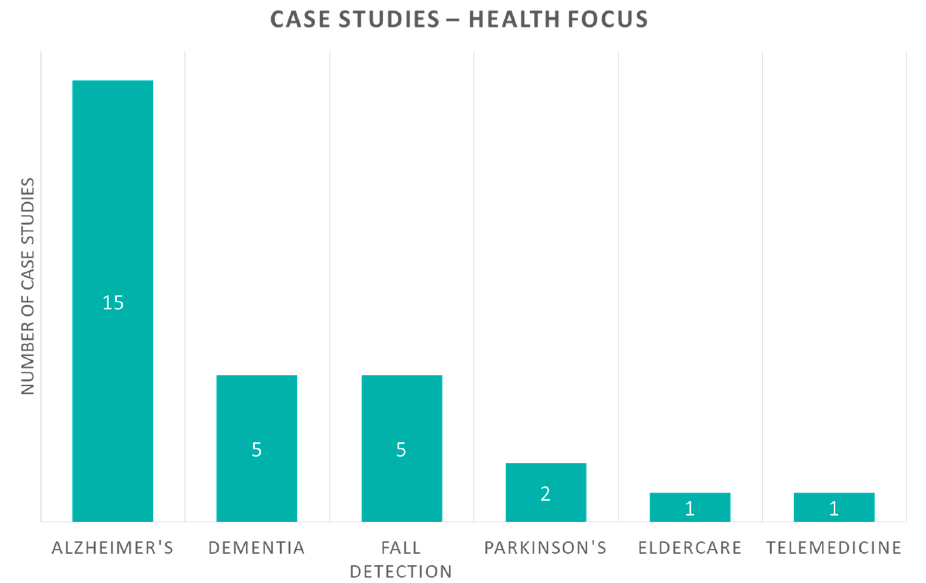
Figure 6. Case study papers according to their health focus.